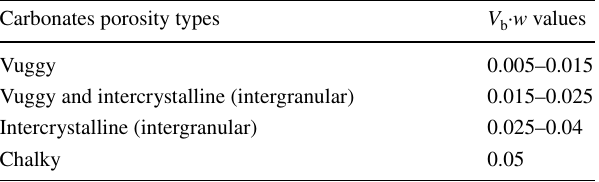
w val- w values (Fertl and Vercellino b ·